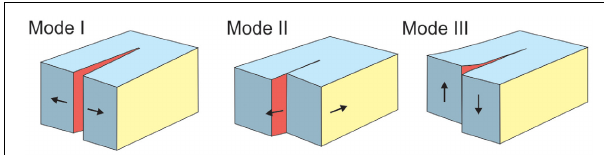
FIGURE 4 | Three main ideal modes of rock fractures. These are mode I, mode II, and mode II cracks. For rock fractures, strike-slip faults are most commonly modeled as mode III (but as mode II if there is a magma chamber/reservoir at the bottom of a through-going fault), whereas dip-slip faults are commonly modeled as mode II (but as mode III if there is a magma chamber/reservoir at the bottom of a through-going fault). Extension fractures (dikes, tension fractures, most joints) are modeled as mode I cracks (cf. Gudmundsson, 2011).